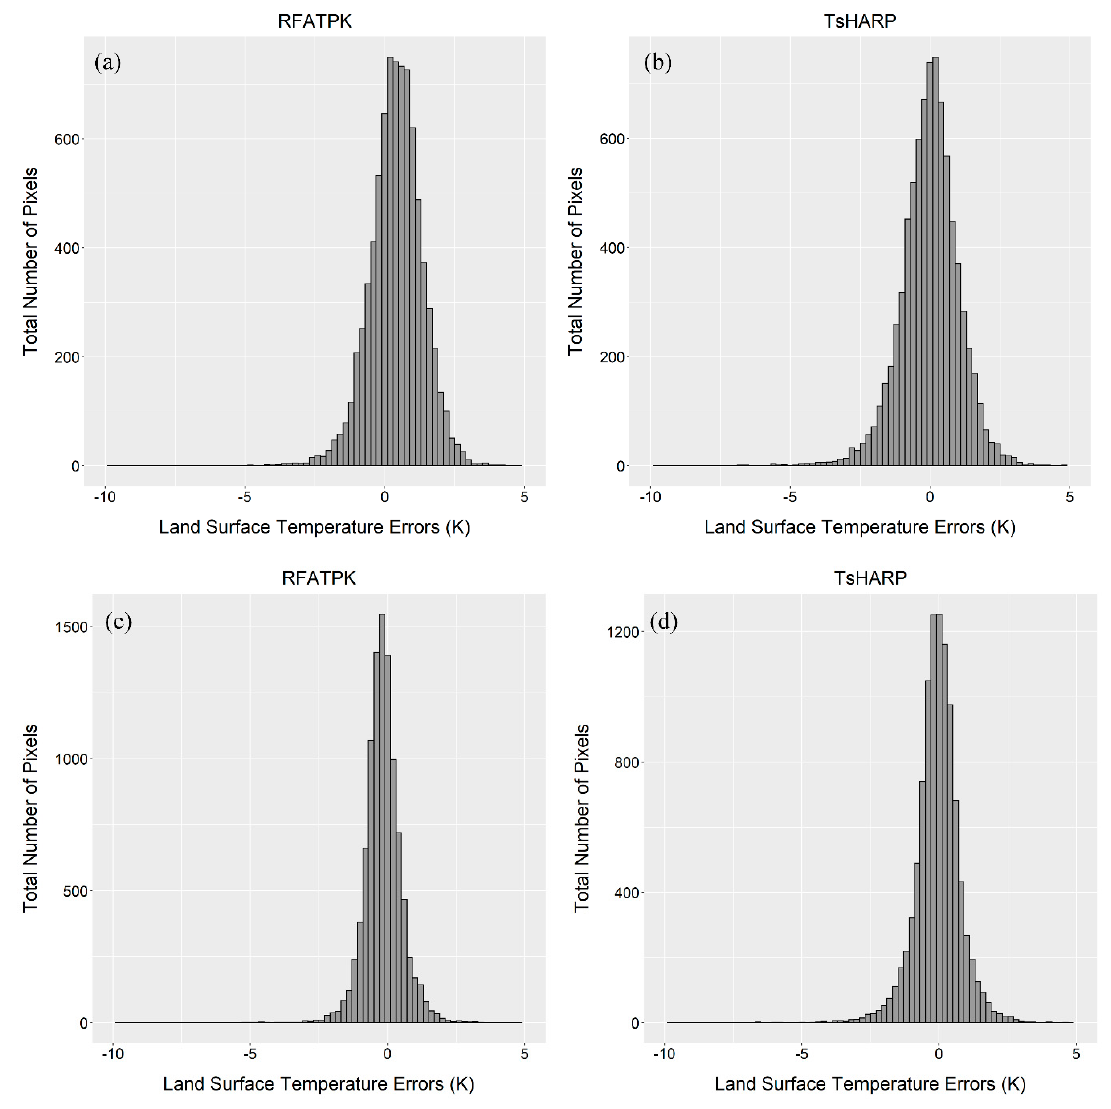
Figure 5 . Error distributions of ( a ) RFATPK LST in region A; ( b ) TsHARP LST in region A; ( c ) RFATPK LST in region B; and ( d ) TsHARP LST in region B.